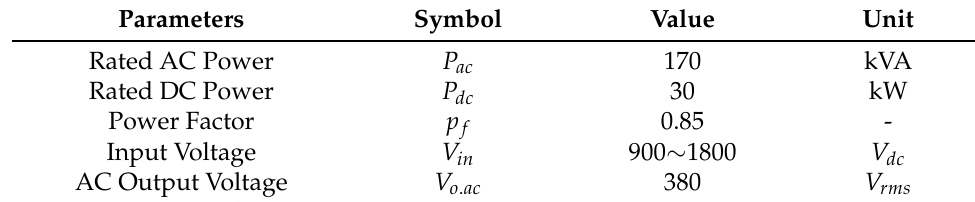
Table 3. Specification of resonant auxiliary power supply for railway vehicles.